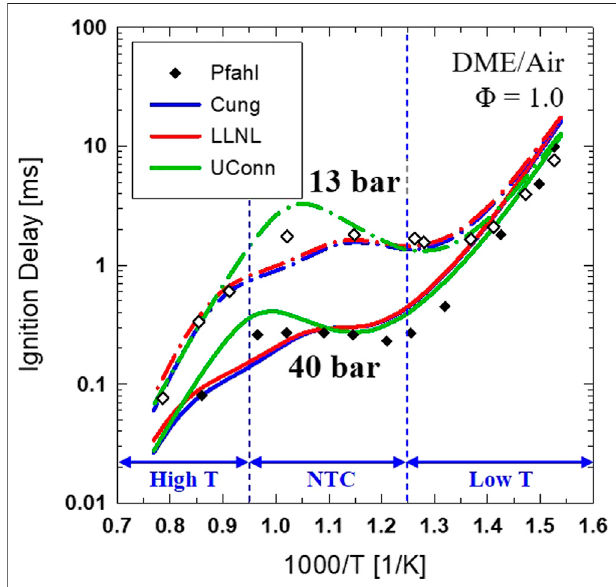
FIGURE 3 | Comparison of computed ignition delay for stoichiometric DME/air reaction using different chemical kinetic mechanisms at an initial pressureof13and40 baroveranambienttemperaturerangeof650 – 1300